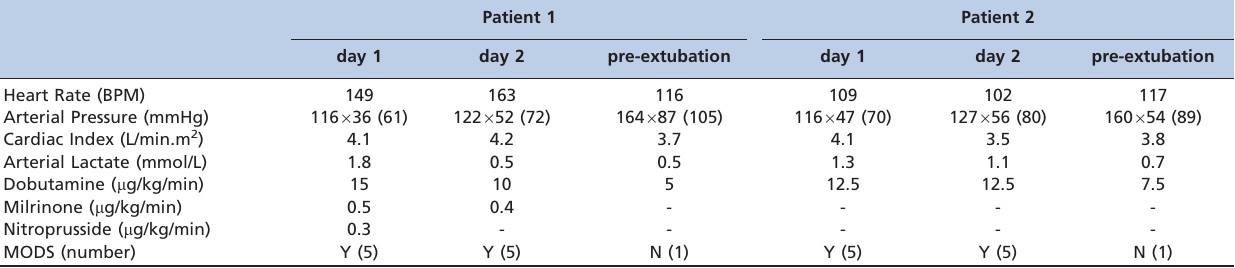
Table 1 - The clinical and laboratory parameters and the drugs used at the moment when the microcirculatory analysis was performed using Sidestream Dark Field